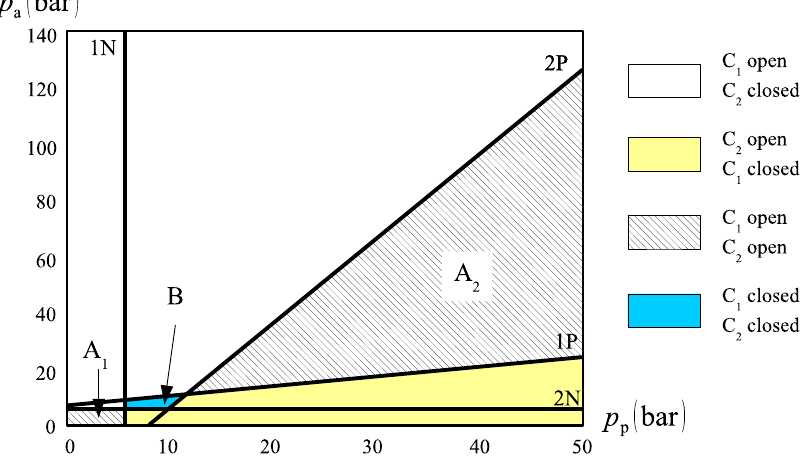
Figure 14. Status of check valves C 1 and C 2 as functions of the cap and rod-side pressures.